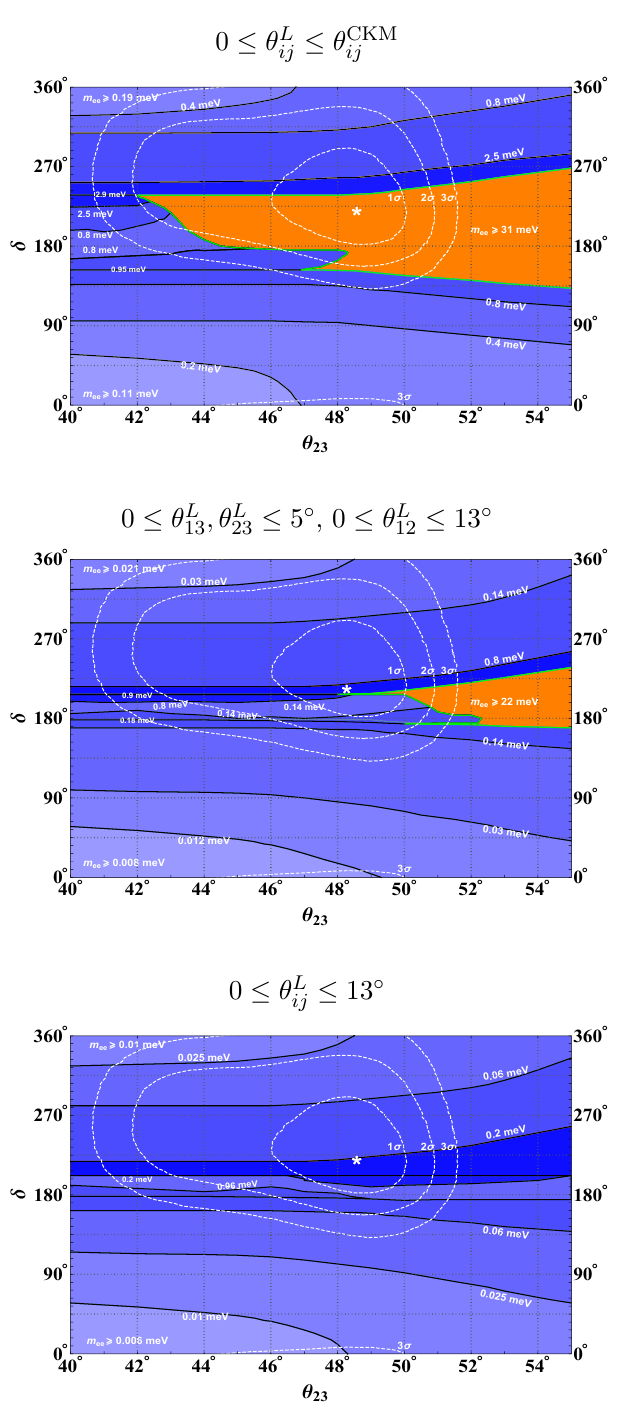
Figure 6 . Isocontour lines for the lower bound on m ee for the same three cases as in (cid:12)gure